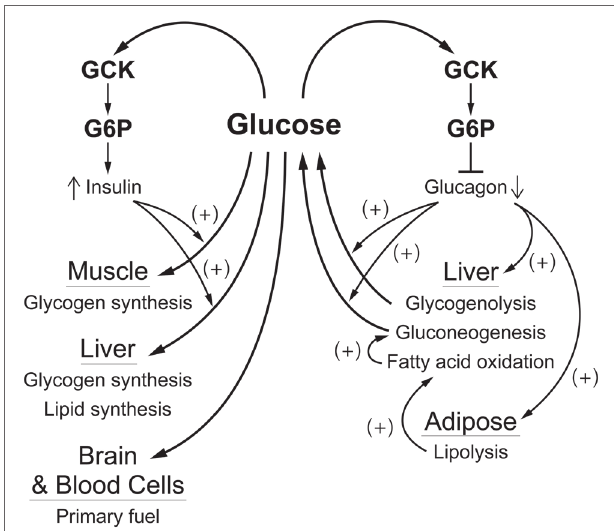
FIGURE 4 | A schematic overview of how glucose regulates blood glucose by affecting α - and β -cells. The blood glucose level, through the activity of GCK which produces G6P as a “second messenger”, regulates release of glucagon from α -cells and of insulin from β -cells. Insulin is responsible for controlling consumption of glucose (removal from the blood), largely for storage as glycogen in muscle and liver. This is opposed by glucagon which is responsible for controlling production of glucose, mostly from liver glycogen and/or gluconeogenesis, and for activating fatty acid oxidation, primarily through production of fatty acids by adipose tissue. This “opposing forces” counter regulatory process is designed to achieve a balance (production equals consumption) at a blood glucose concentration near 5